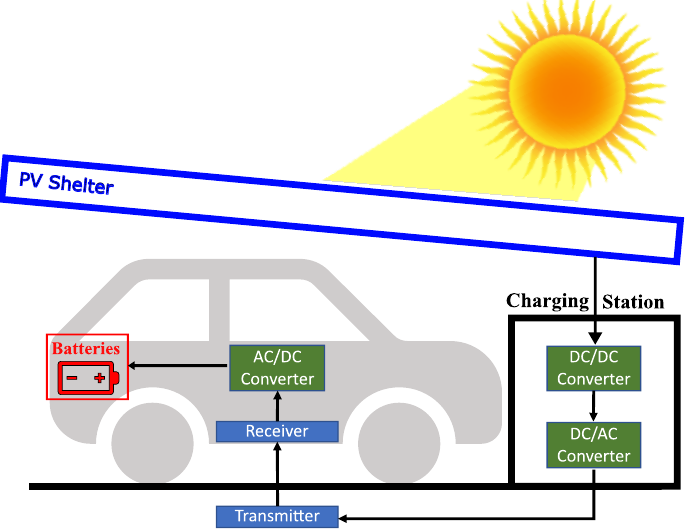
Figure 1. IPT system architecture for EV charging